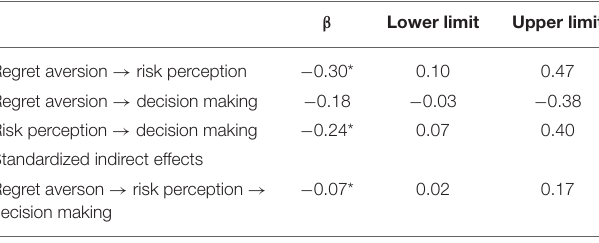
TABLE 7 | Direct and indirect effects and 95% confidence